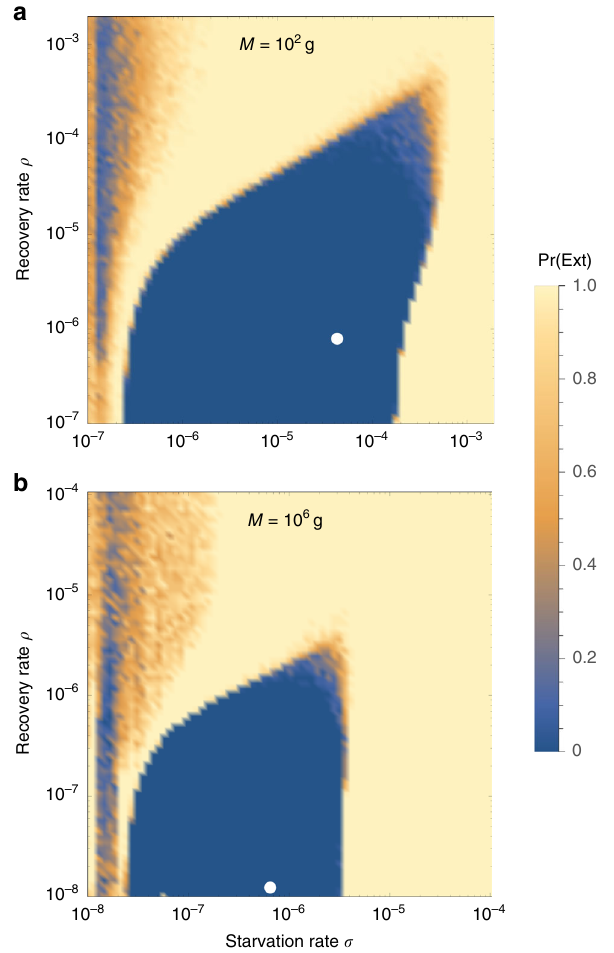
Fig. 3 Probability of extinction for a consumer with a M = 10 2 g and b M = 10 6 g as a function of the starvation rate σ and recovery rate ρ , where the initial density is given as ( XF * , XH * , R * ), where X is a random uniform variable in [0, 2]. Note the change in scale in b . Extinction is de fi ned as the population trajectory falling below 0.2× the allometrically constrained steady state. The white points denote the allometrically constrained